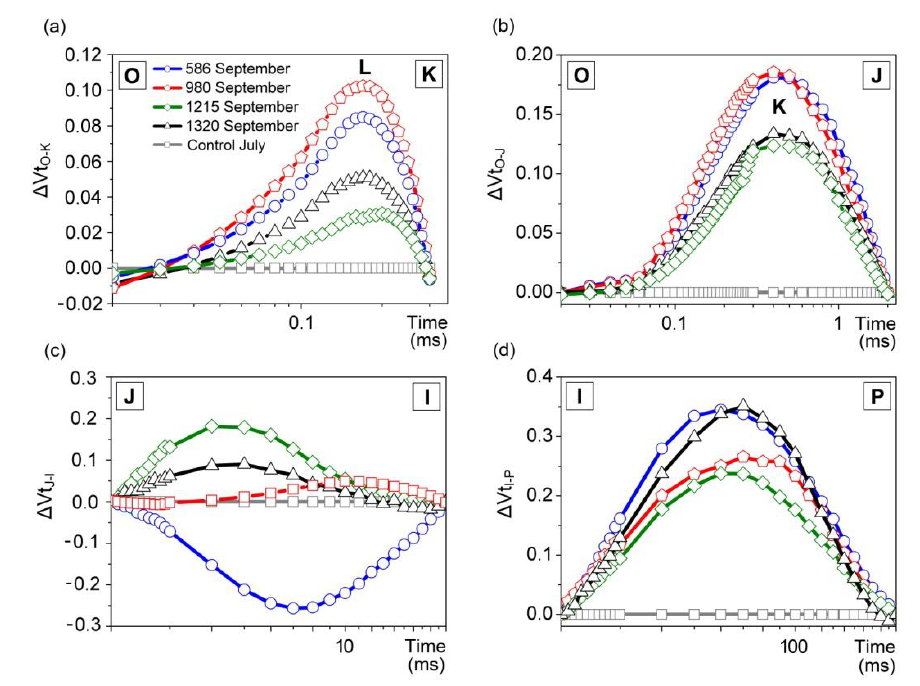
Figure 2. Differential fluorescence curves ( ∆ Vt) of green alder ( Alnus viridis ) leaves for phases: ( a ) O-K, ( b ) O-J, ( c ) J-I, and ( d ) I-P, normalized to values corresponding to characteristic points in transitions of the chlorophyll fluorescence induction curve. The curves for individual sections were obtained by subtracting the Chl a fluorescence values recorded in July from the curves obtained in September. As a control for each field test stand, the curve obtained in July was adopted, as described in Methods.